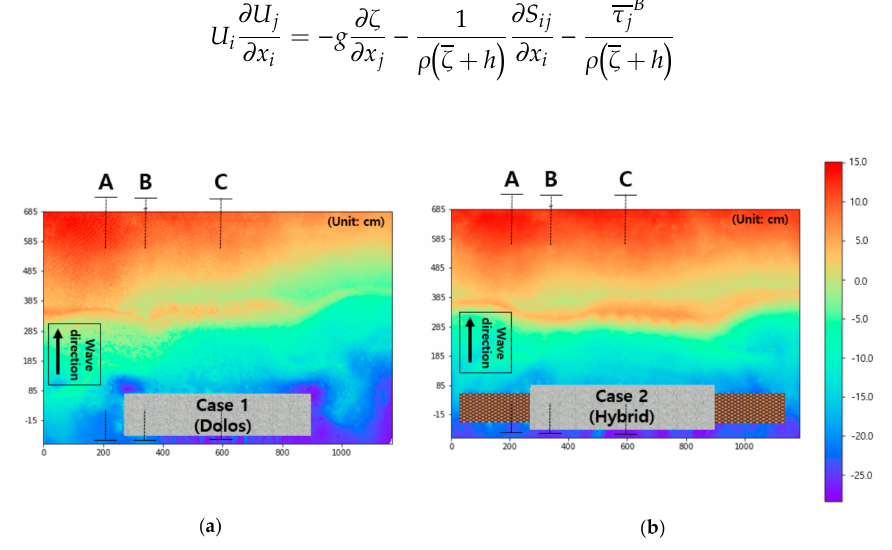
Figure 9. Results of the 3D morphological changes after 20 h by structure type (Case 1: dolos; Case 2: hybrid (dolos with the coral reef)): ( a ) morphological changes after 20 h when the submerged breakwater was applied (Case 1) and ( b ) morphological changes after 20 h when the hybrid method was applied (Case